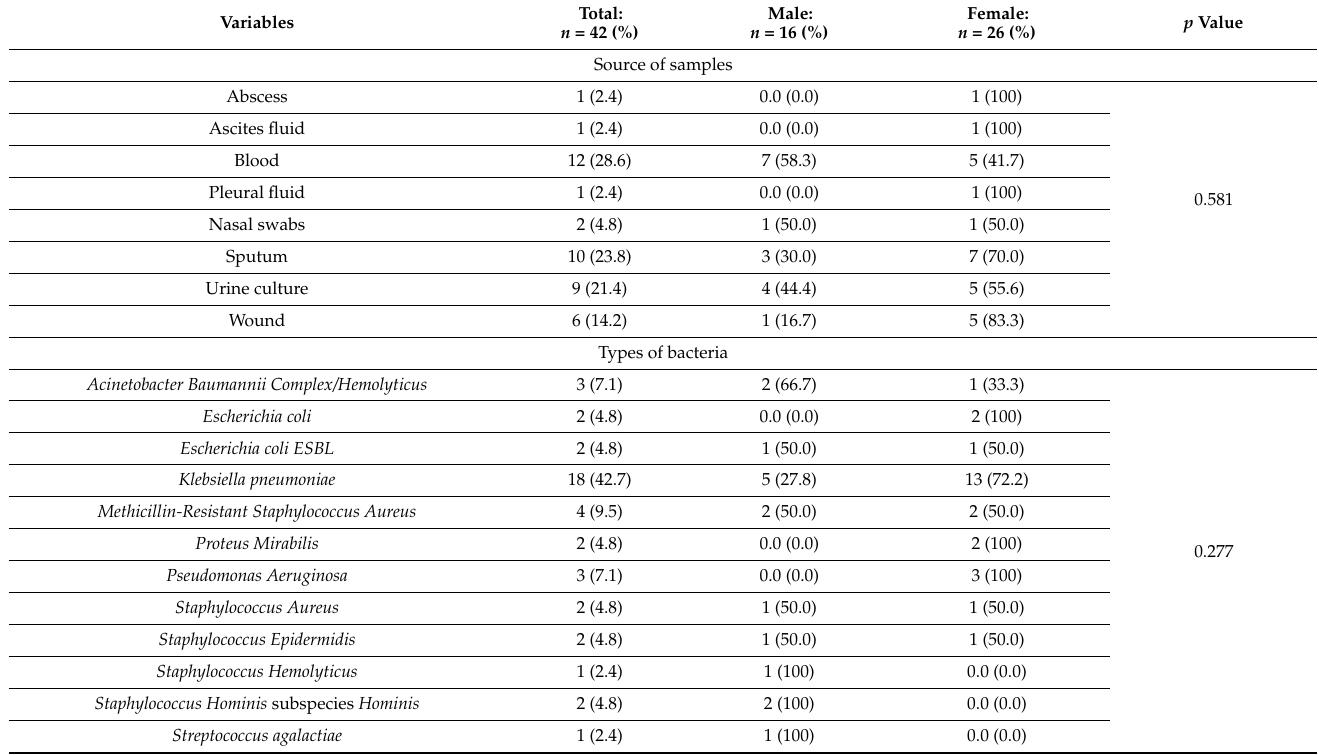
Table 2. The source of samples and types of bacteria among the study participants by gender.